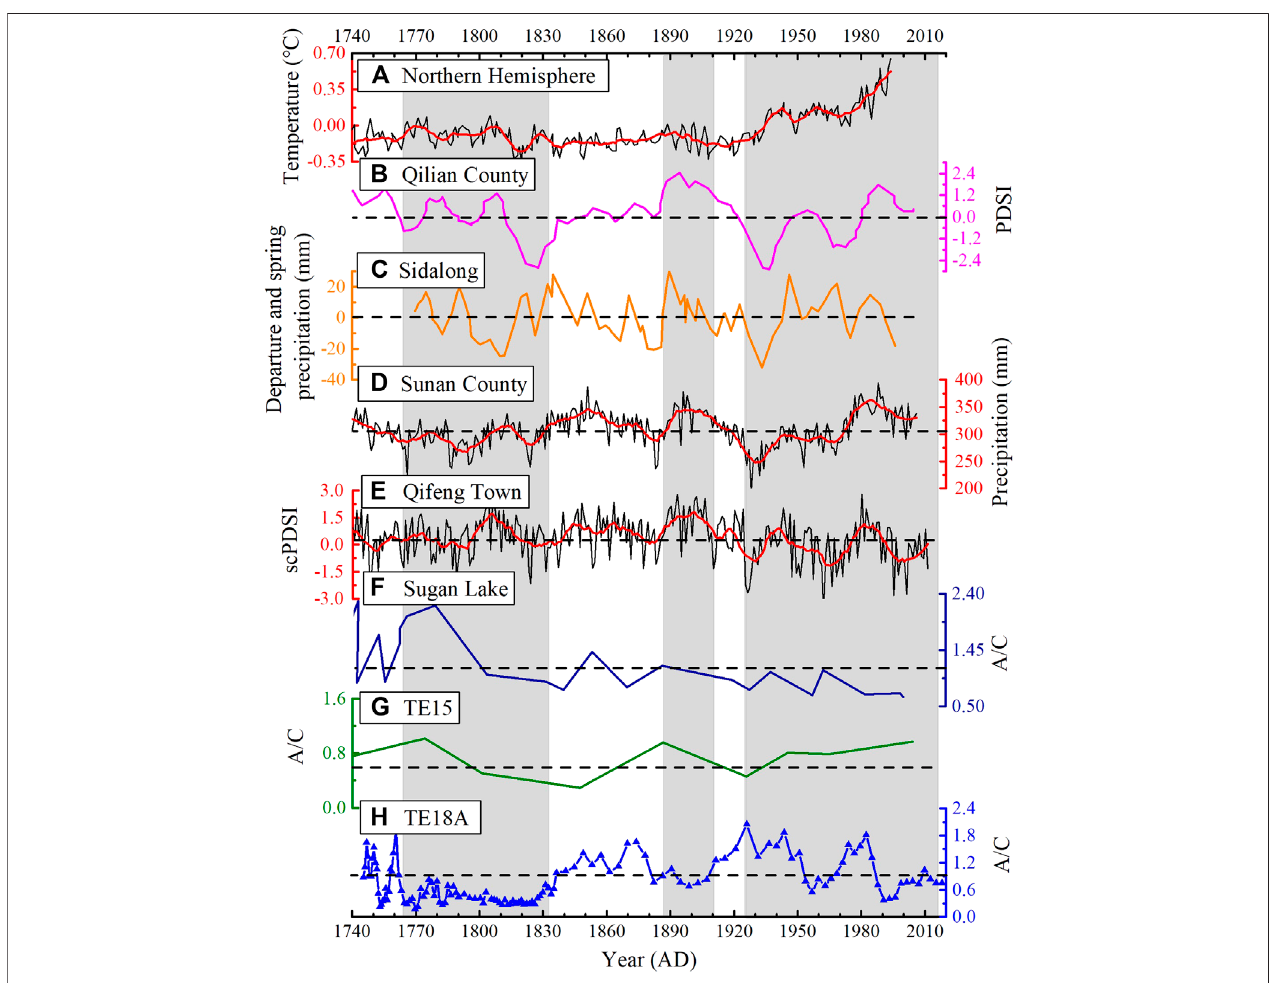
FIGURE 5 | Comparison of the humidity reconstruction for Tian ’ E Lake based on the A/C ratio with tree-ring and pollen records from Qilian Mountains and other temperaturesignals. (A) NorthernHemispheretemperature(Mannetal.,1998). (B) PalmerDroughtSeverityIndex(PDSI)fromMaytoJuly,atree-ringrecordfromcentral Qilian Mountains (Sun and Liu, 2013). (C) Tree-ring-based precipitation anomaly from Sidalong, in the central Qilian Mountains (Wang et al., 2001). (D) Annual precipitationreconstructionsince775basedontree-ringrecordsfromtheQilianMountains(Zhangetal.,2011). (E) scPDSI-basedtree-ringrecordsfromQifengin the western Qilian Mountains (Yang et al., 2019). (F) Pollen A/C ratio from Sugan Lake (Zhang et al., 2010). (G) Pollen A/C ratio from core TE15 of Tian ’ E Lake in the western Qilian Mountains (Zhang et al., 2018). (H) Pollen A/C ratio from core TE18A of Tian ’ E Lake in the western Qilian Mountains (this study). Horizontal dashed lines representtheaveragevalue.Signi fi cantdifferencesbetweenthepollenandtree-ring-basedhumidityreconstructionsareindicatedbygrayshadedareas.Theredcurves are the result of 20-point smoothing.